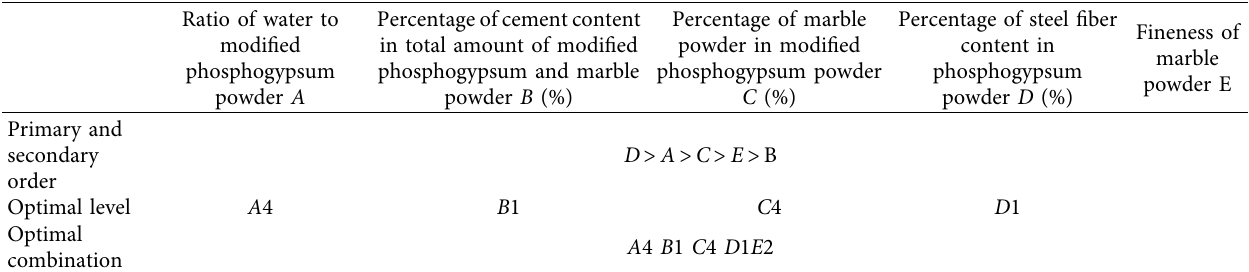
Table 15: Statistical table of the influencing factors of the 3d electrical